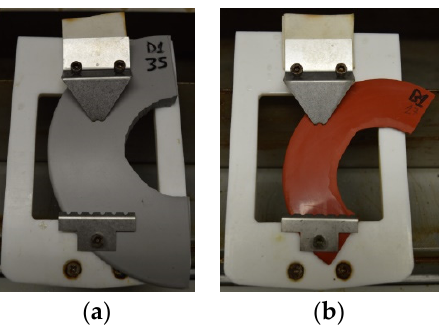
Figure 4. A big ( a ) and a small ( b ) half shed of different composite insulators used as specimens for the inclined plane test. the inclined plane